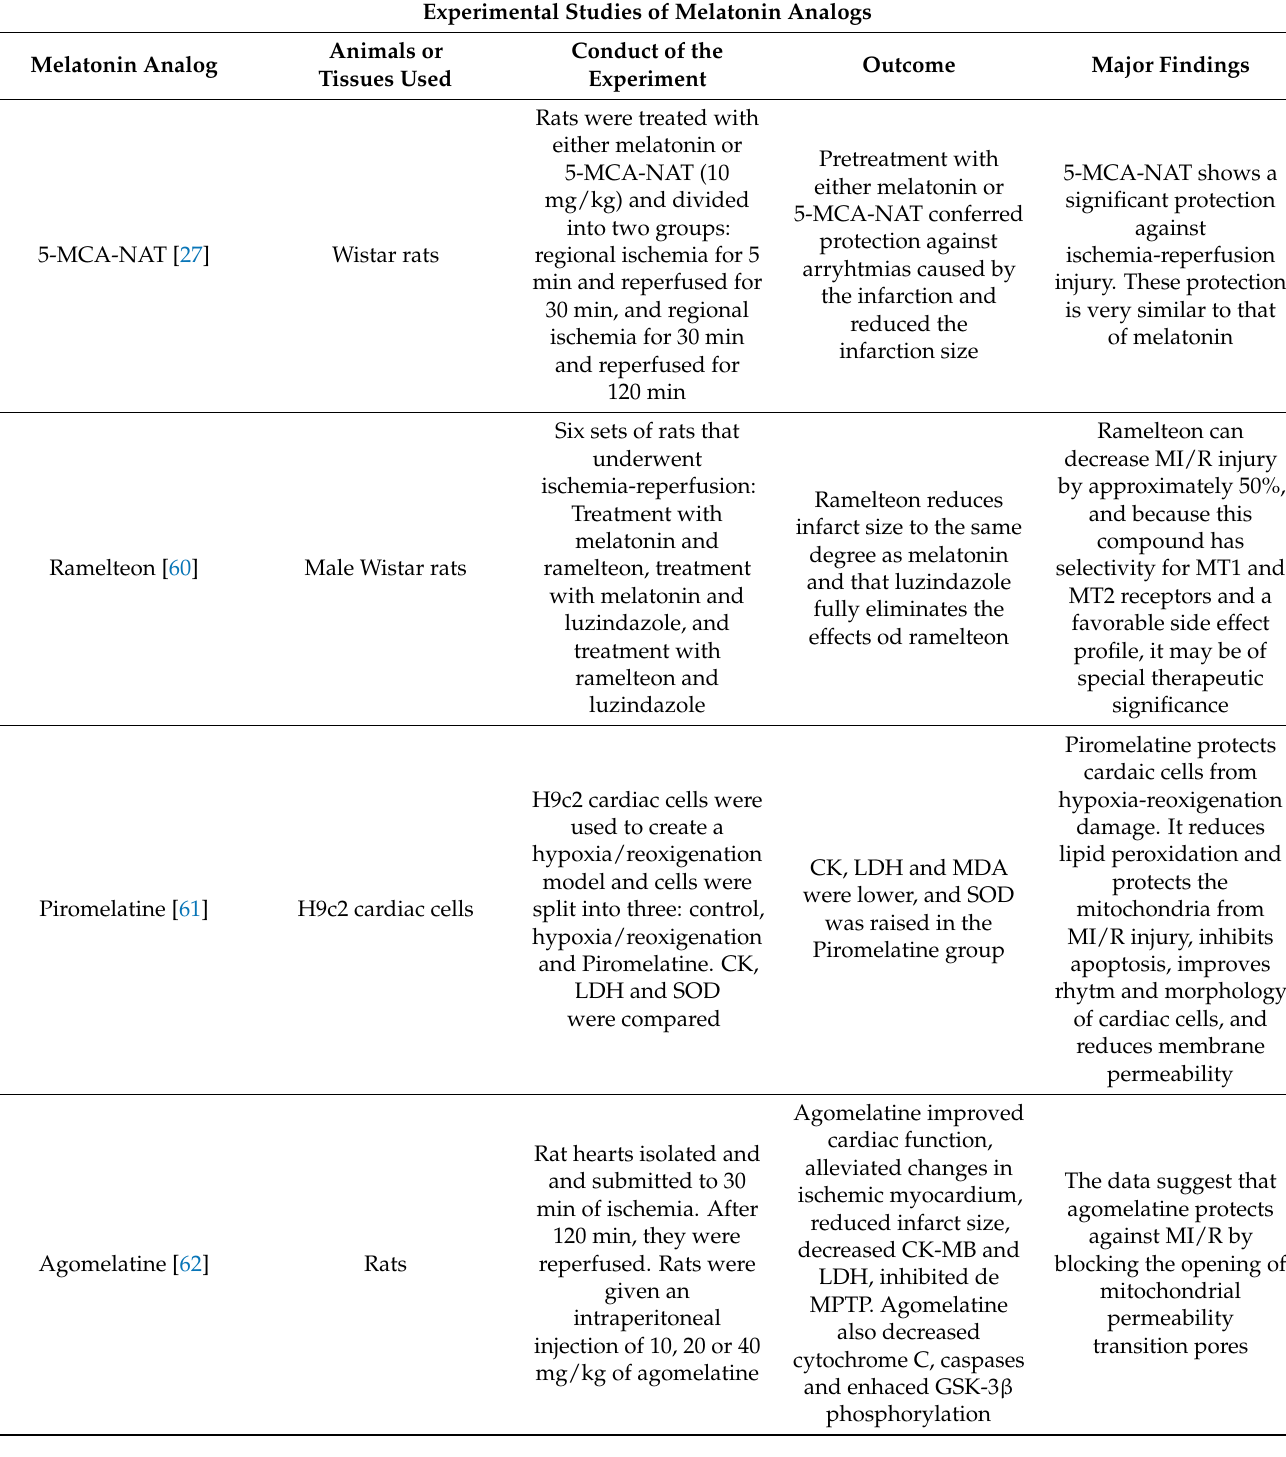
Table 3. Experimental studies that assessed melatonin’s analogs efficacy for improving the effects of ischemia-reperfusion